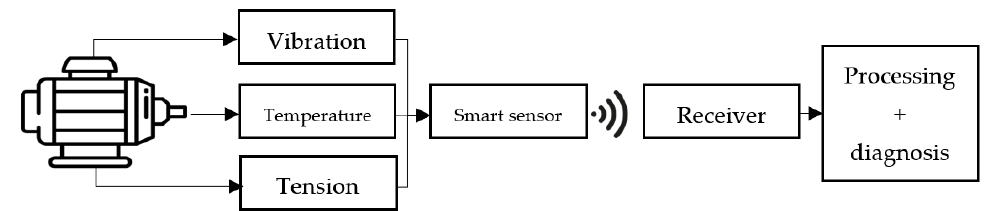
Figure 10. Logic diagram for monitoring an electric motor by the smart sensor.